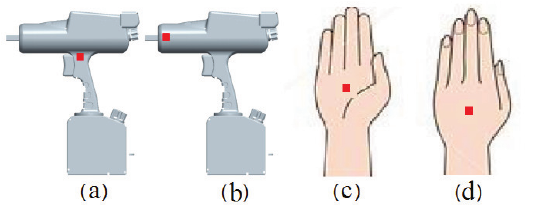
Figure 3. Location of acceleration sensors: ( a ) handle measuring point; ( b ) output shaft measuring point; ( c ) palm measuring point; and ( d ) opisthenar measuring